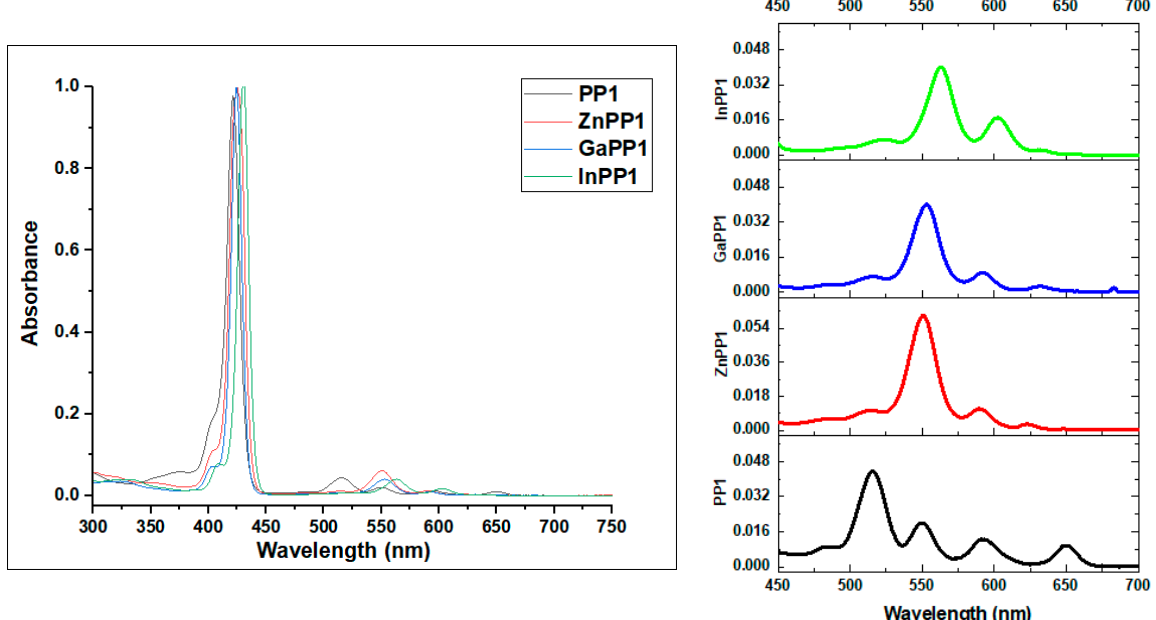
Figure 1. ( Left ) Normalized absorption spectra of PP1 and the corresponding metal complexes in toluene. ( Right ) Spectra zoom in the Q band region.